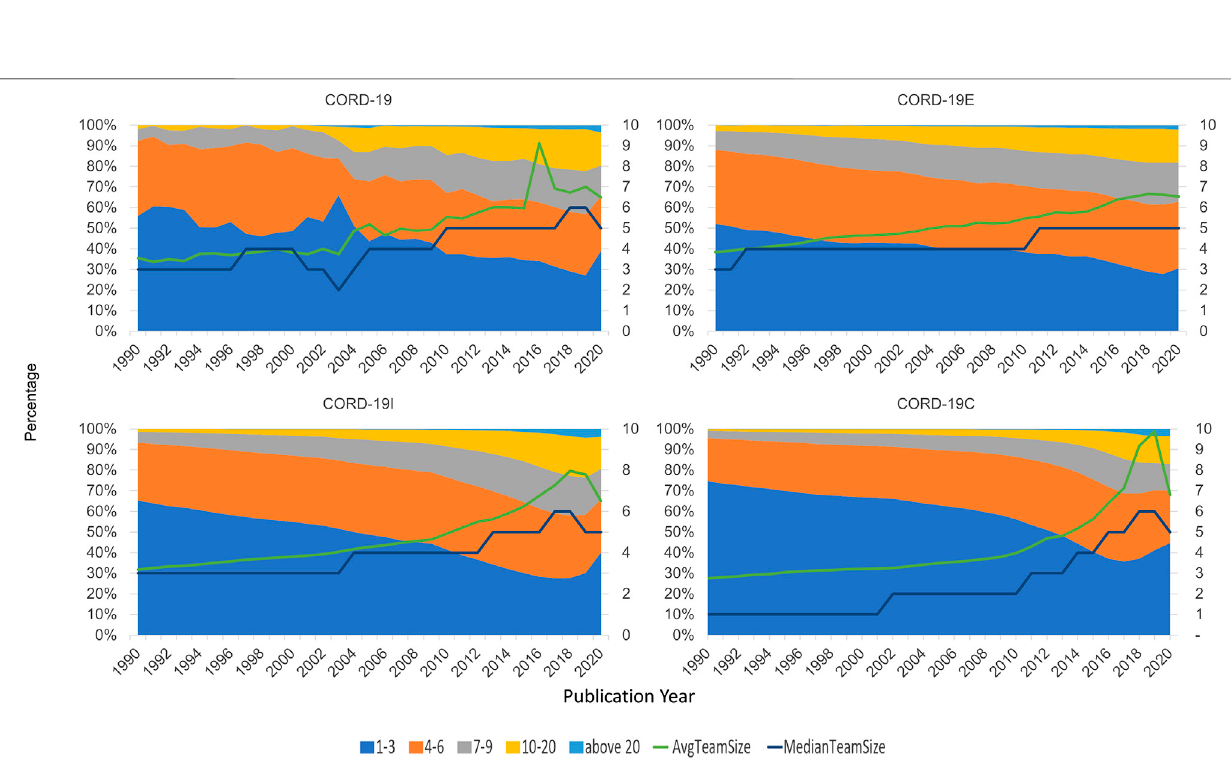
Frontiers in Research Metrics and Analytics |